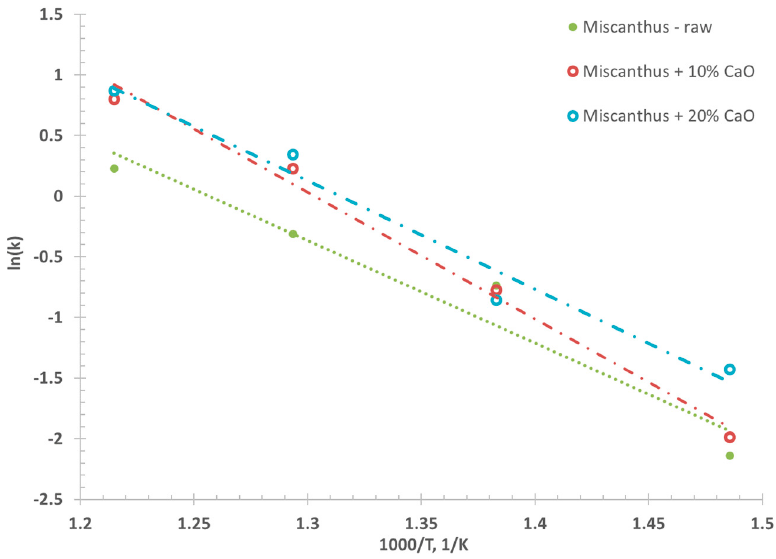
Figure 11. Arrhenius plot for pyrolysis of Miscanthus—influence of catalyst (dotted lines are trend lines). Table 1. Activation energy and pre-exponential (frequency) factor for fast pyrolysis of Miscanthus.